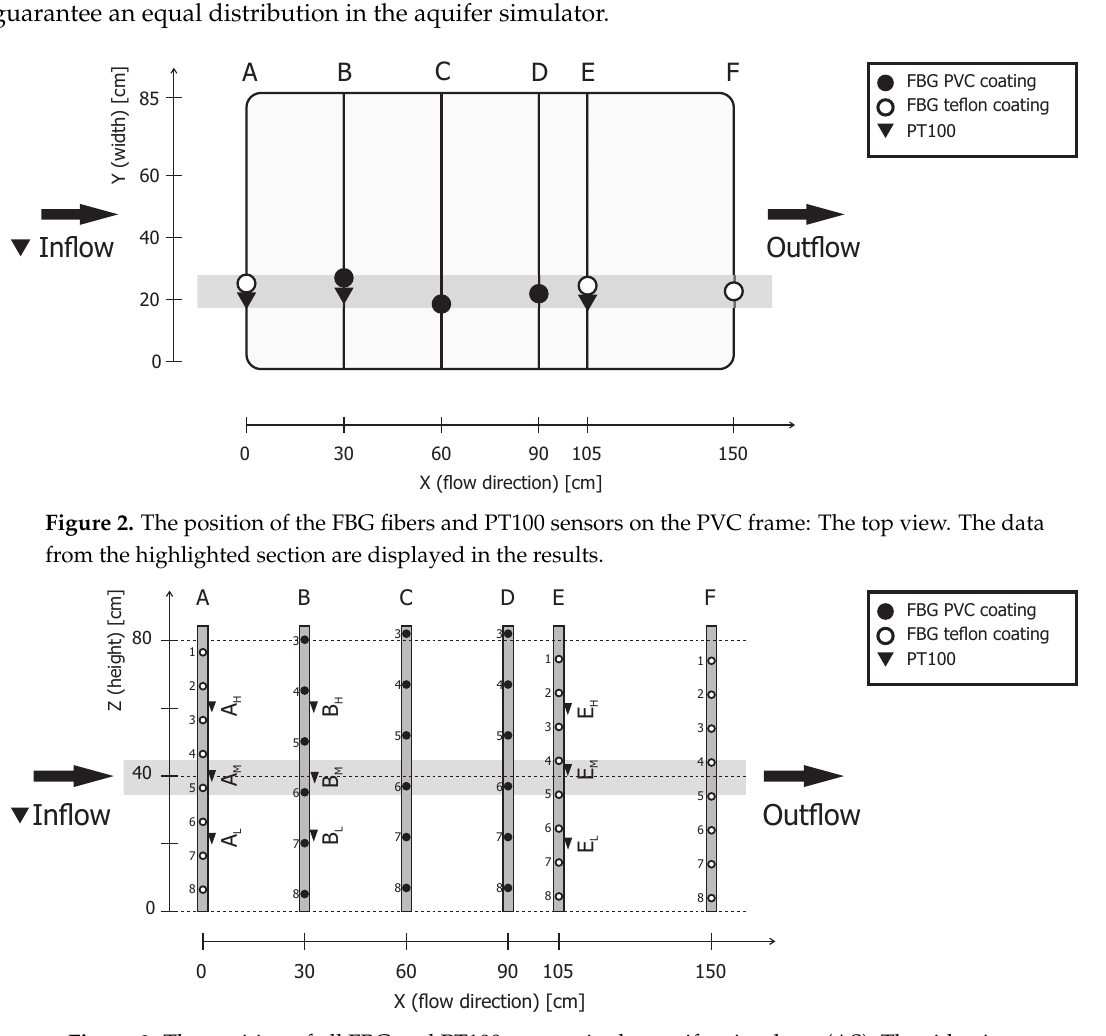
Figure 3. The position of all FBG and PT100 sensors in the aquifer simulator (AS): The side